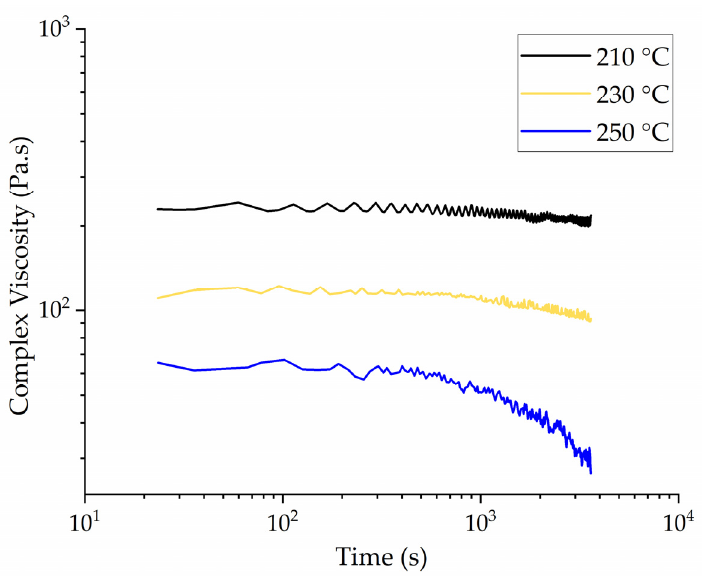
Figure 4. Rheograms representing a time sweep of PLA at different temperatures, showing a loss of complex viscosity at 250 °C.